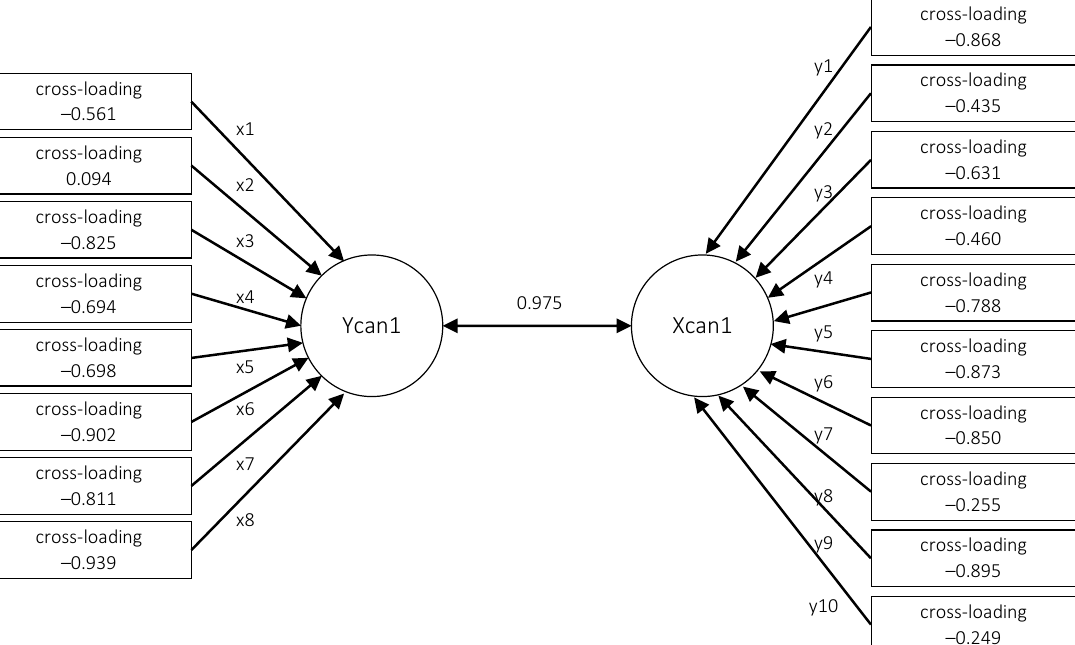
Figure 2. Canonical correlation and cross-loading for first canonical variates (Xcan1 and Ycan1)